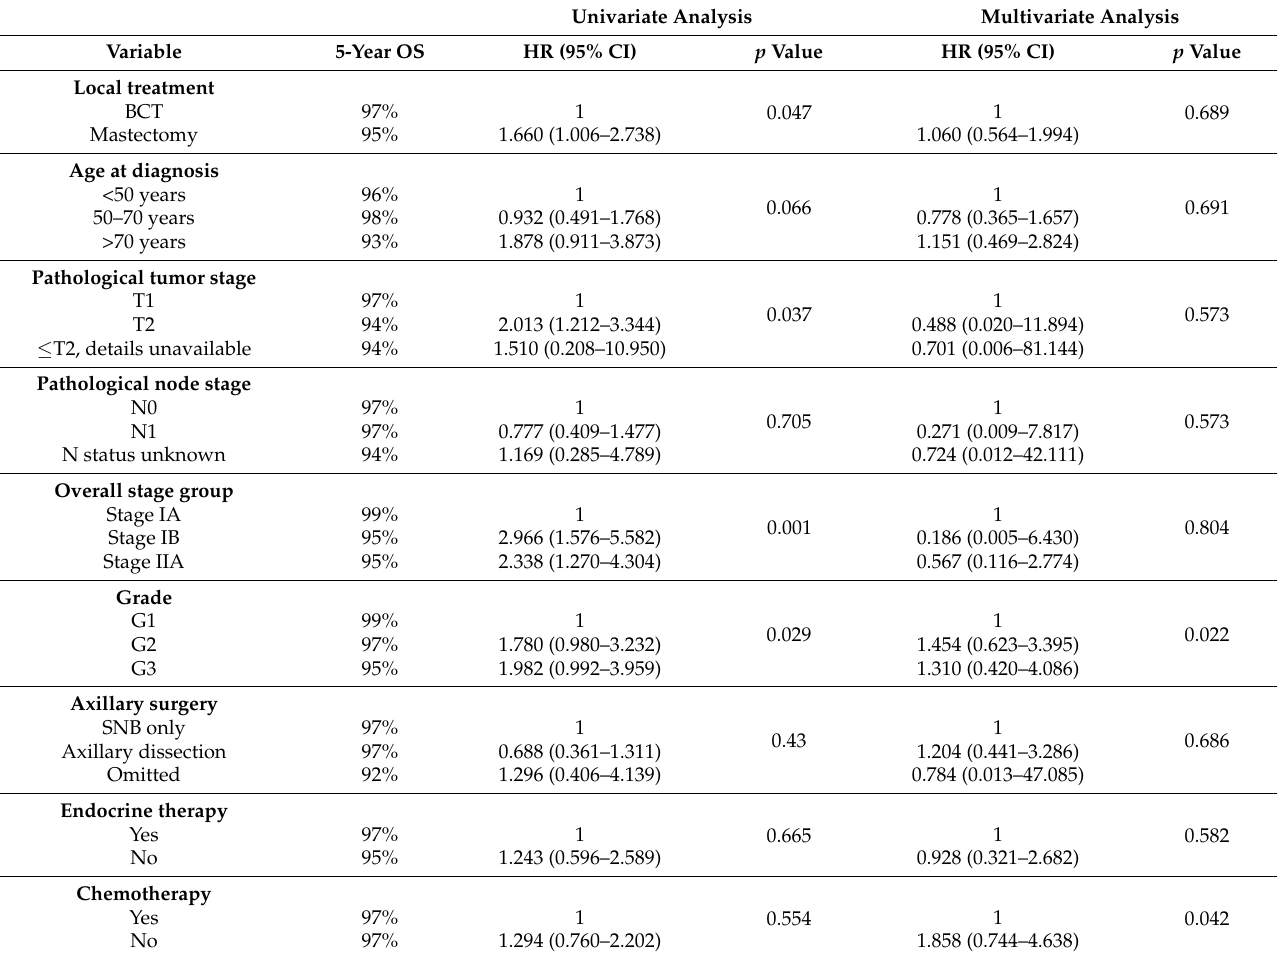
Table 5. Univariate and multivariate Cox regression analysis for 5-year overall